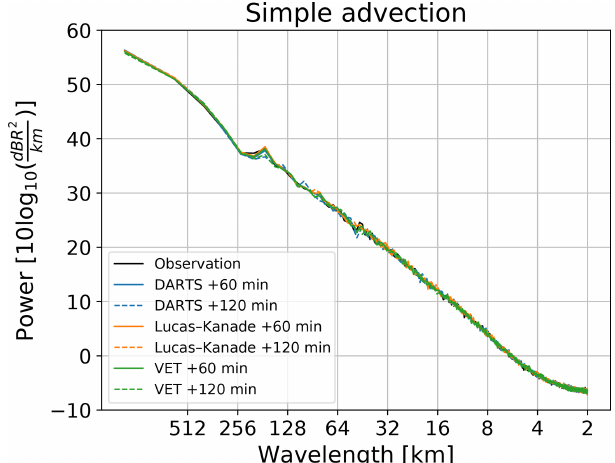
Figure 8. Numerical diffusion analysis of the semi-Lagrangian ad- vection scheme using radially averaged Fourier spectra for different optical flow methods and different forecast lead times. The now- casts are for FMI event no. 3 (16:00UTC on 28 September